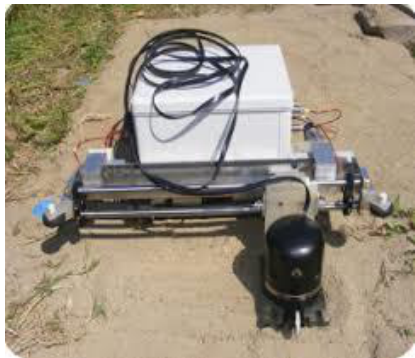
Figure 19. HSR on a robotic scanning platform [88].